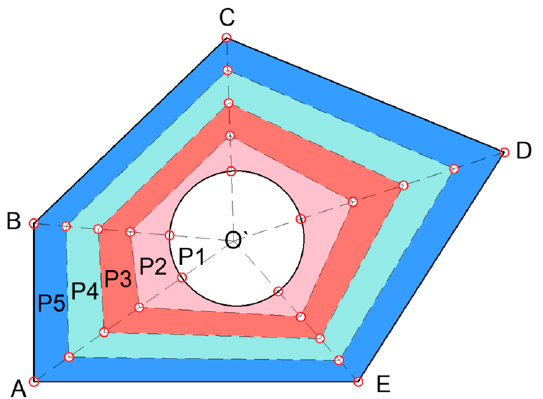
Figure 8. The region of von Mises stress.